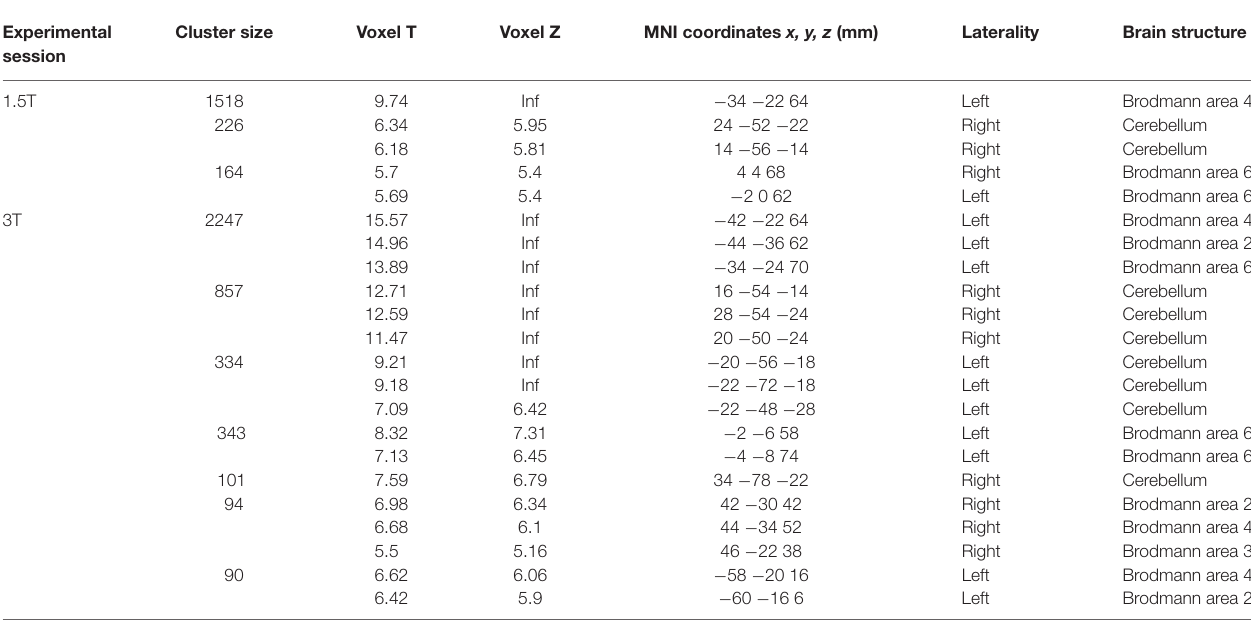
TABLE 2 | Brain areas of activation during the finger motor task with the right hand wearing the glove (see Figure 9) for a representative subject at 1.5 T and 3T. Experimental Cluster session